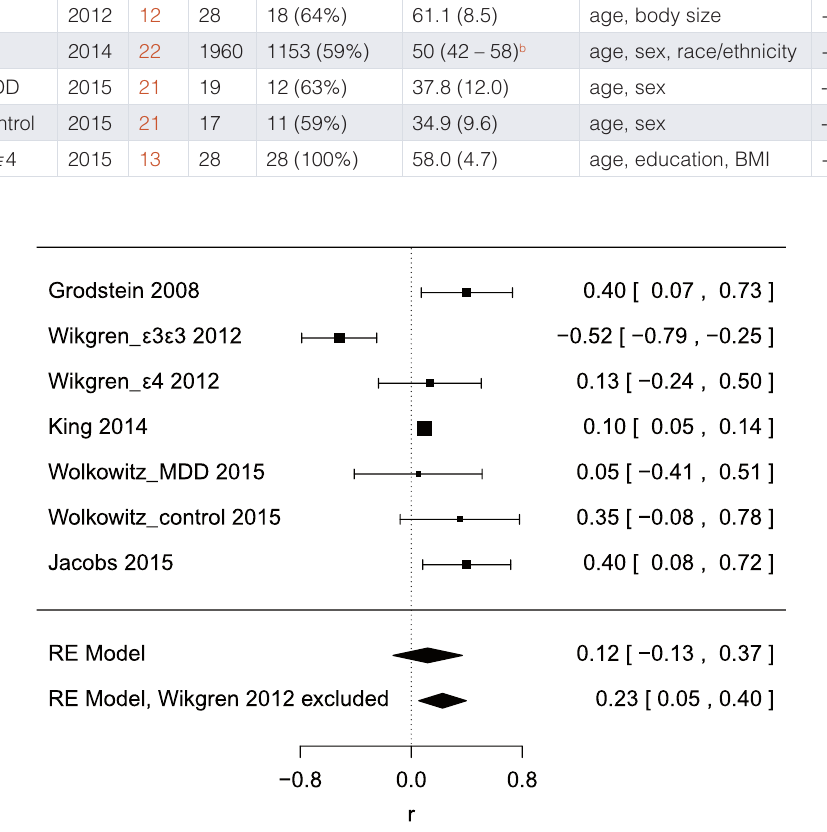
Figure 2. Forest plot. Diamonds at bottom show estimates for a random-effects model including all studies and an estimate when excluding one study as a sensitivity analysis.